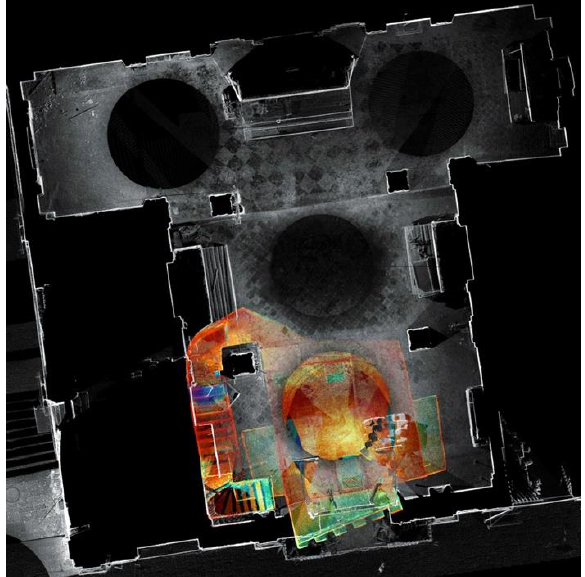
Figure 6. The point cloud treated with different colors and densities to build a special three-dimensional model Similarly to what was done for the Castel Capuano staircase, then, by modulating the density and color of the point cloud, a representation was done to visualize, through a play of transparency, the spacial relationship between the underground crypt, the interior of the upper church and the placement of the original pillars. (Figure 6)